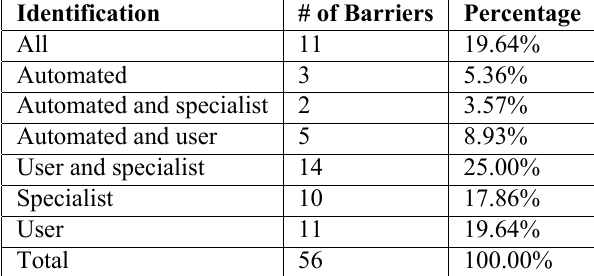
Table 8. Problems found on the web platform